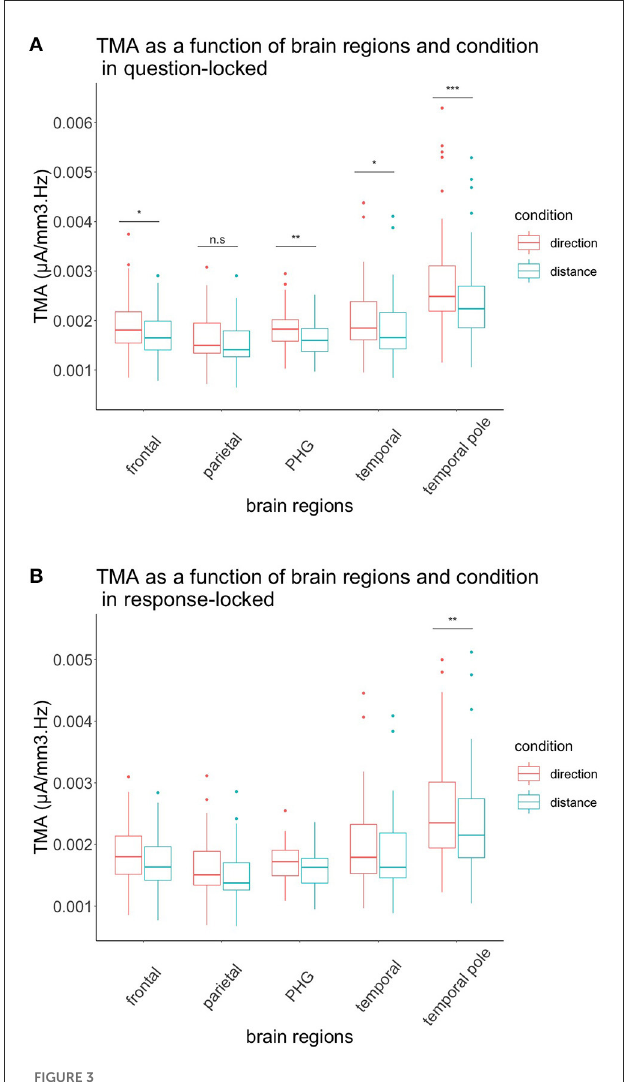
FIGURE3 TMA of brain regions and conditions according to their interval. (A) Representation of the TMA of each brain region according to their condition in the question-locked. All brain regions, except the parietal region, showed significant differences between distance and direction, with the direction condition being greater than the distance condition. (B) Representation of the TMA of each brain region according to their condition in the response-locked. Only the temporal pole showed significant differences between the two conditions, with the direction condition being higher than the distance condition. n.s: p > 0.05, * p < 0.05, ** p < 0.01, *** p < 0.001.